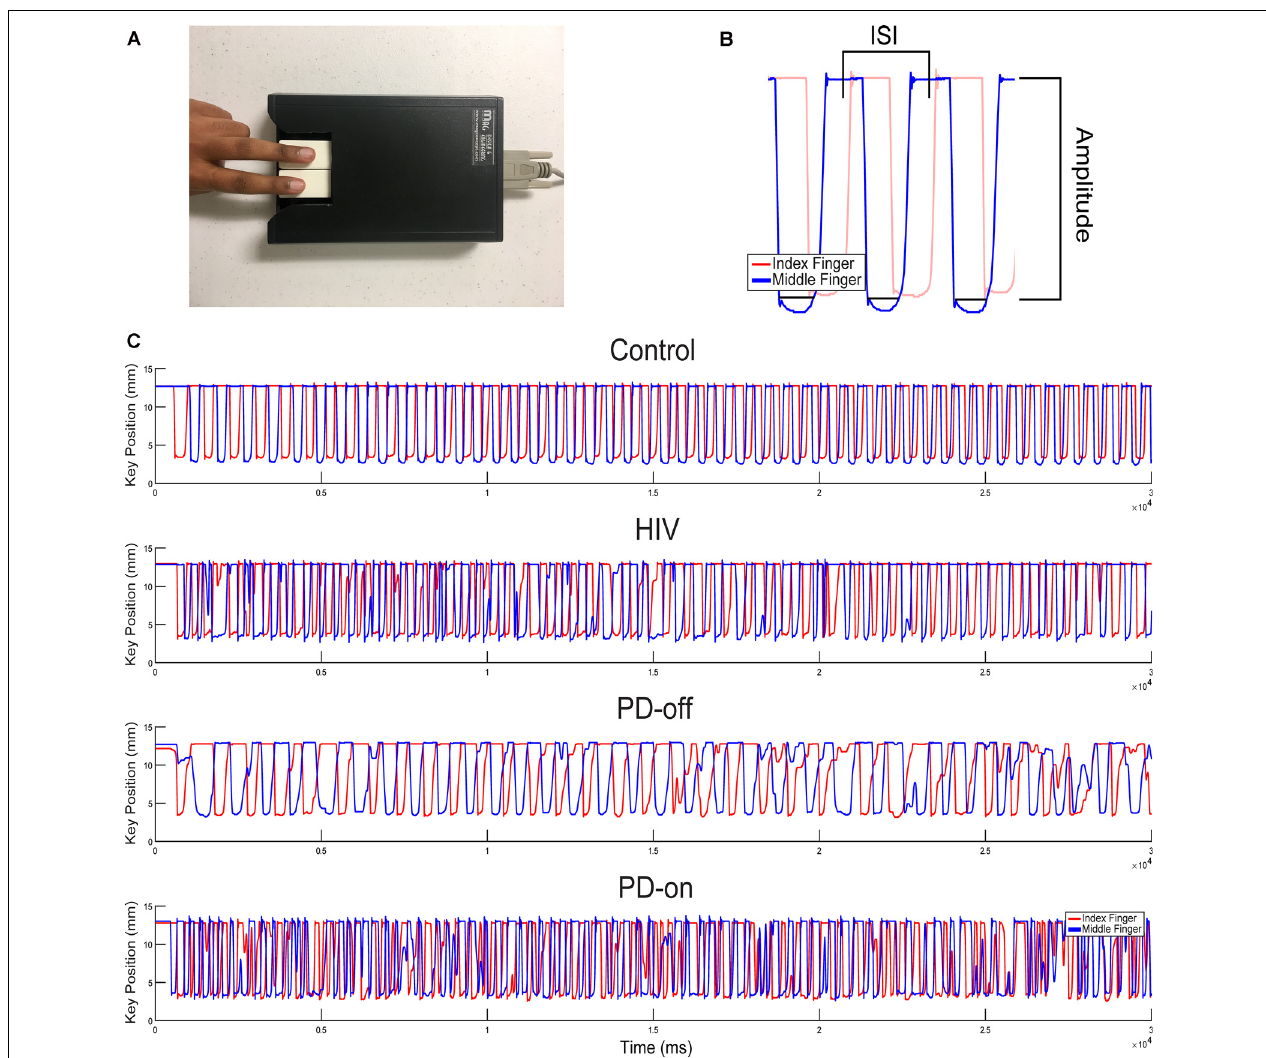
FIGURE 1 | Quantitative digitography (QDG) and sample rapid alternating finger tapping (RAFT) traces. (A) Index and middle finger placement on the engineered keyboard (QDG). (B) Three cycles of RAFT demonstrating the ISI (inter-strike-interval) and peak-to-peak amplitude of a finger strike cycle. (C) Representative 30-s RAFT traces from the MN (More affected, Non-dominant) hand of control, HIV, and PD off and on dopaminergic medication (highest to lowest